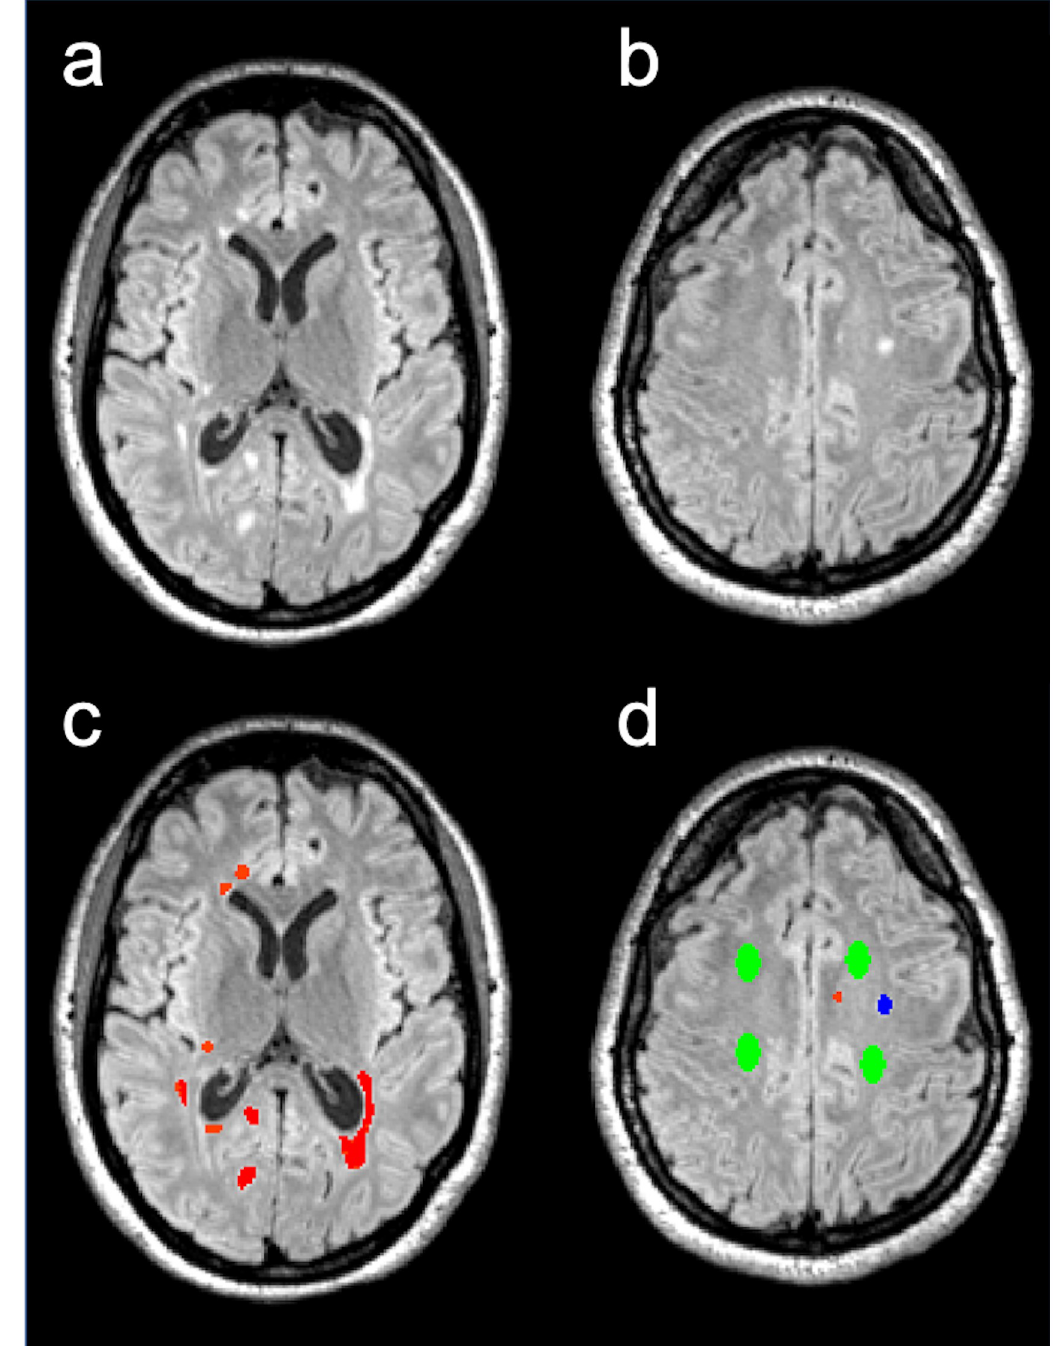
Fig 2. Example of lesion outlining and ROI placement. FLAIR images of an MS patient before lesion outlining (a, b) and after lesion outlining (c, d). FLAIR lesion = red, black holes = blue, NAWM = green.